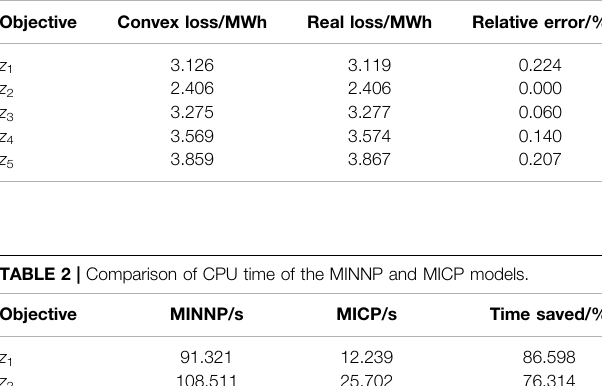
TABLE 1 | Comparison of the convex and real network loss of SOPs.